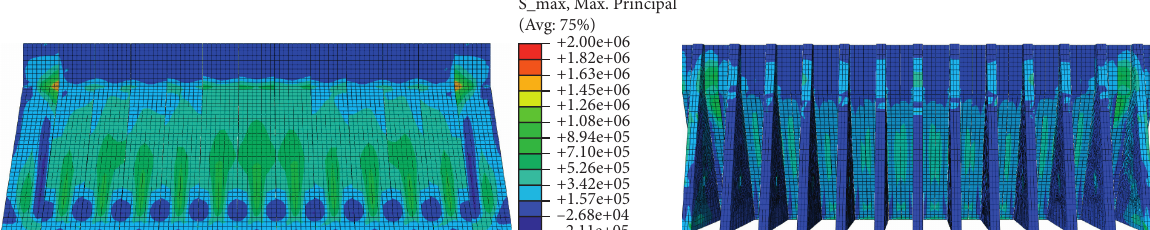
Figure 20: Maximum envelope of maximum principal stresses at upstream and downstream of buttress dam induced by the Swedish design earthquake considering only stream